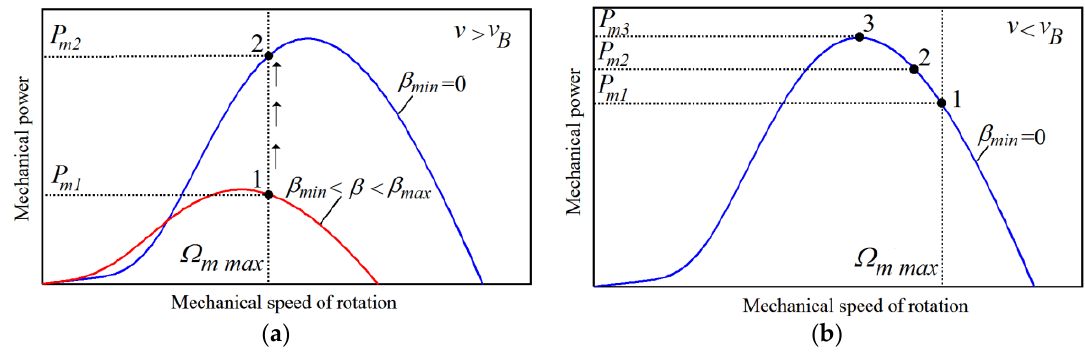
Figure 6. Wind turbine power-speed characteristic, ( a ) Speed regulation by adjusting the pitch angle; ( b ) Increasing wind turbine output by reducing rotational speed.